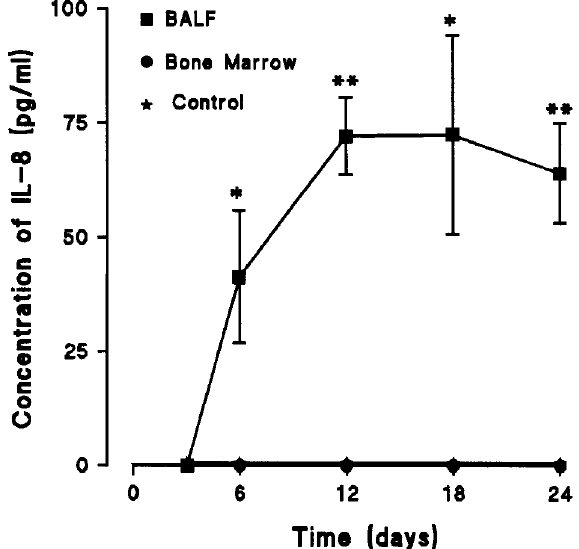
FIG. 3. Inhibition of IL-8 release into supernatants of LPS- stimulated guinea-pig adherent peritoneal cells pre-treat- ment with rIL-5. Data are as means ± SEM ( n = 4). Asterisks indicate differences between the amount of IL-8 released by LPS-stimulated adherent peritoneal cells pre-incubated with or without rIL-5, * P < 0.05 and ** P < 0.01. Diamonds indicate differences in the amount of IL-8 released by LPS-stimulated adherent peritoneal cells pre-treated with rIL-5 in the absence or presence of anti-IL-5 Ab, © P < 0.05 and ©© P <